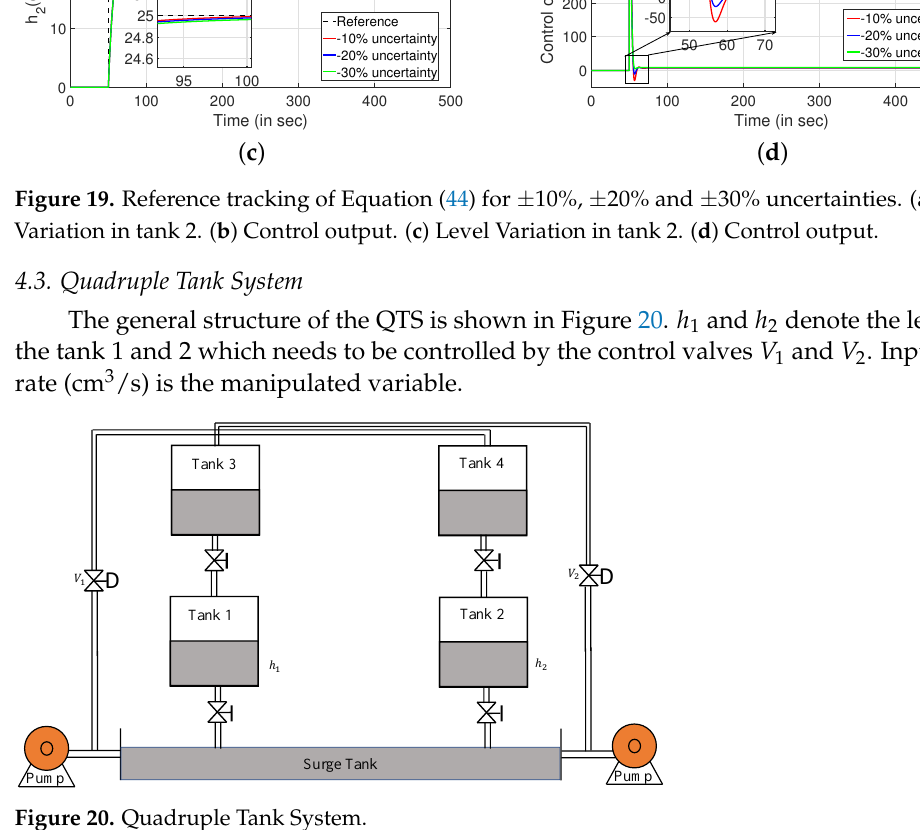
Figure 20. Quadruple Tank